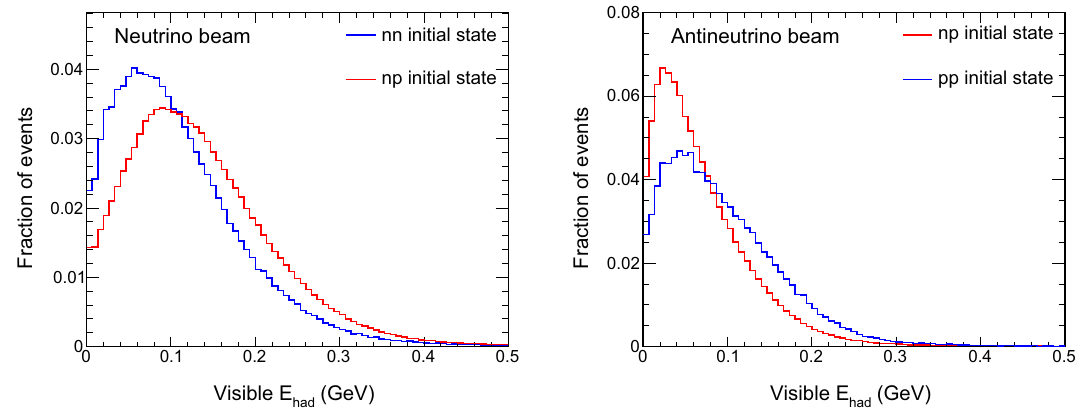
Fig. 9 Visible hadronic energy distribution for simulated Empirical MEC interactions composed of np initial state pairs vs. nn pairs in the neutrino beam (left) and np vs. pp pairs for the antineutrino beam (right) Fig. 10 Neutrino energy distributions for various MEC neutrino models, rescaled as described in text (left), and then taken as a ratio to GENIE Empirical MEC, with systematic uncertainty envelope (dashed curve,